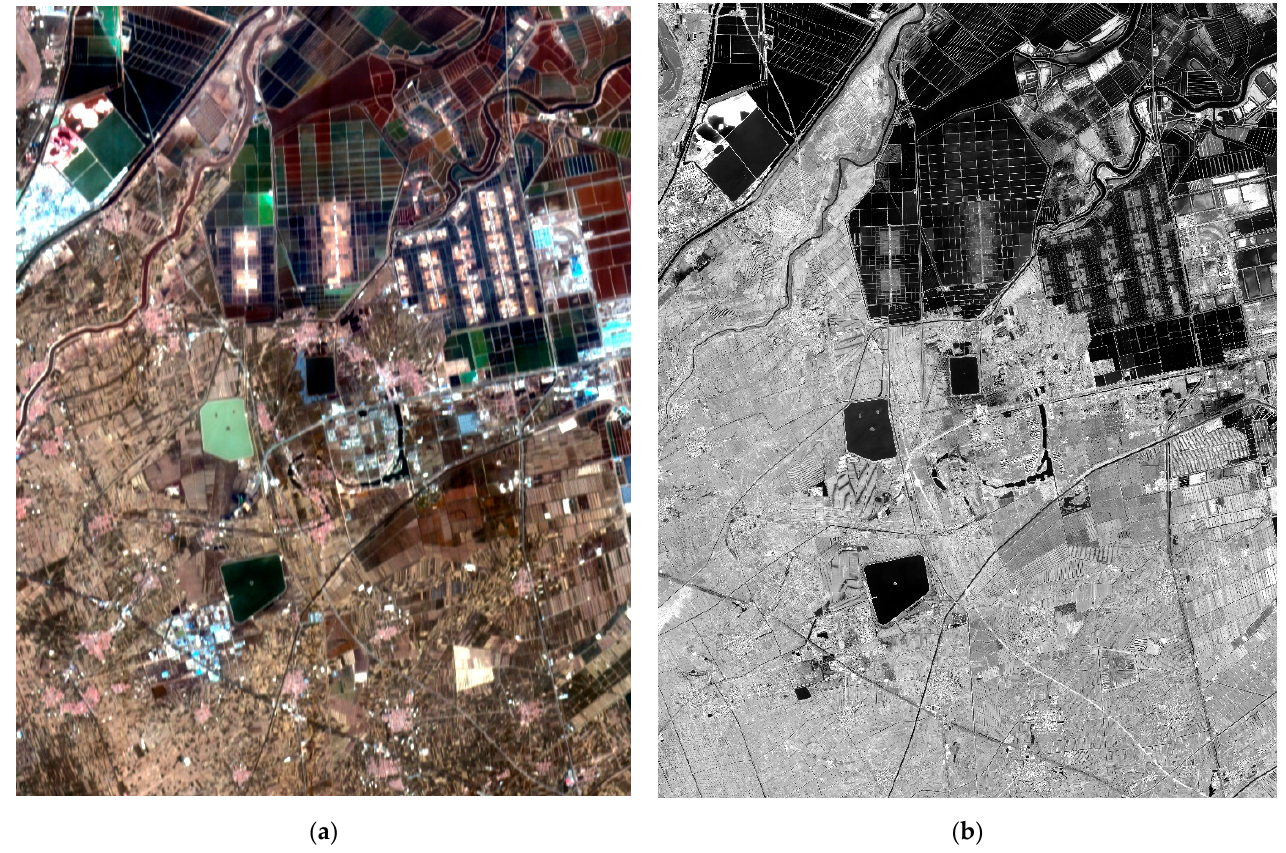
Figure A1. ZY1E hyperspectral image (spatial resolution is 30 m) and GF-7 panchromatic image (spatial resolution is 0.8 m) registered by the method in this paper, which have a resolution difference of about 37.5 times. ( a ) A hyperspectral image of ZY1E. ( b ) A panchromatic image of GF-7.